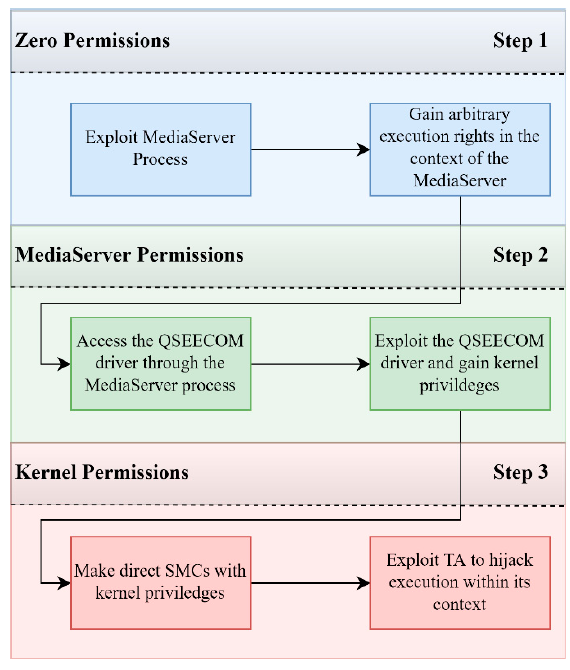
Figure 6. Privilege Escalation to